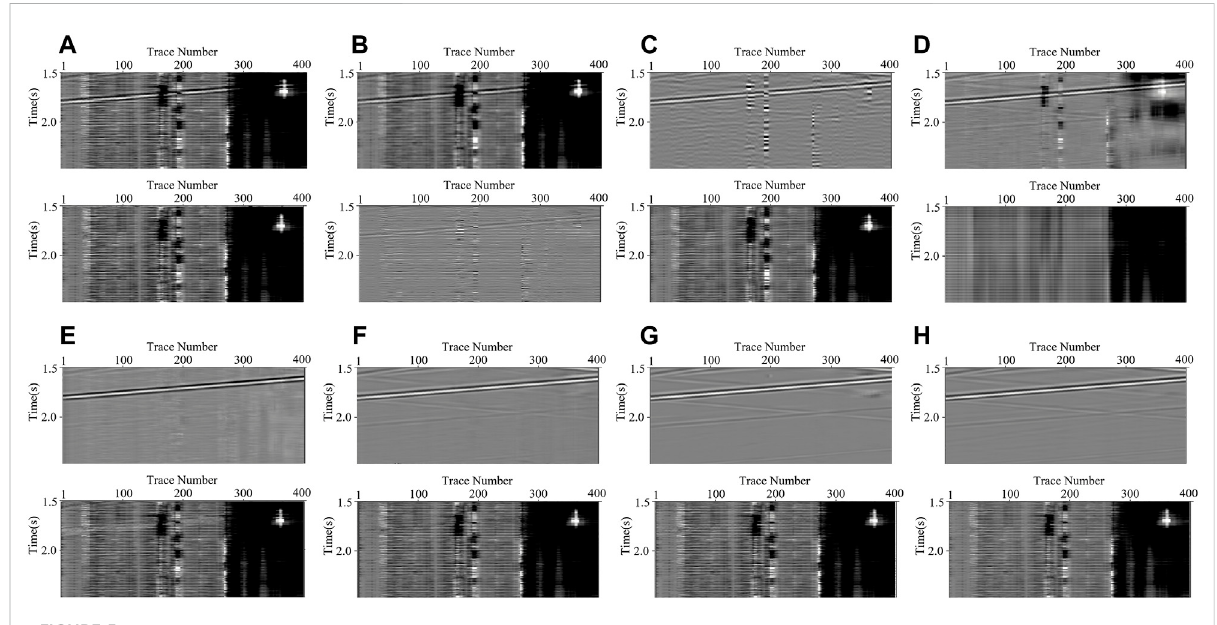
FIGURE 5 The enlargements for the results shown in the yellow blocks in Figure 4: (A) the enlargements for the clean data and the added DAS noise, and (B – H) represent the enlarged processing results of TFPF, BPF, RPCA, DnCNN, U-Net, RED-Net, and MDD-Net, respectively.